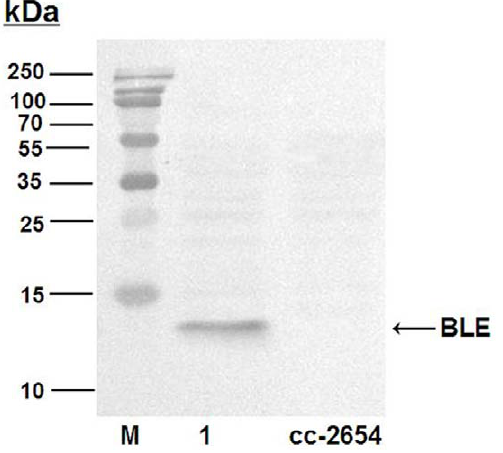
Figure 5. Western blotting analysis of the transformants MT-B using monoclonal anti-BLE antibody. The soluble protein of CC- 2654 (2) were used as control, the soluble protein of transformants MT- B (1) was detected by Western blotting.